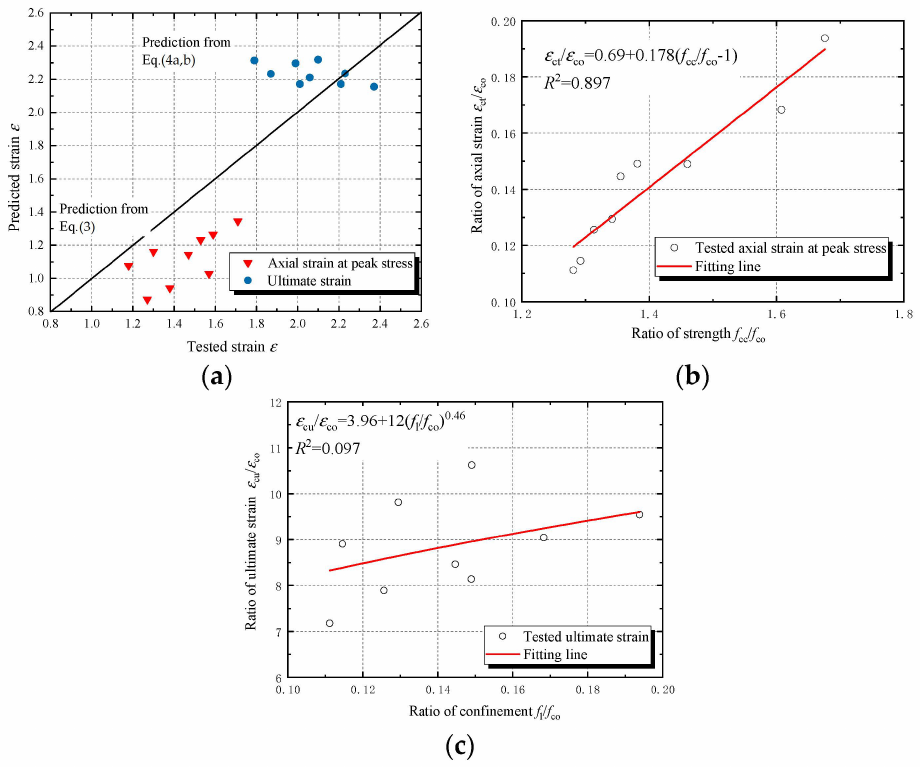
Figure 11. Strain models: ( a ) comparison of predicted strain and tested strain, ( b ) regressed analysis of axial strain model at peak stress and ( c ) regressed analysis of ultimate strain